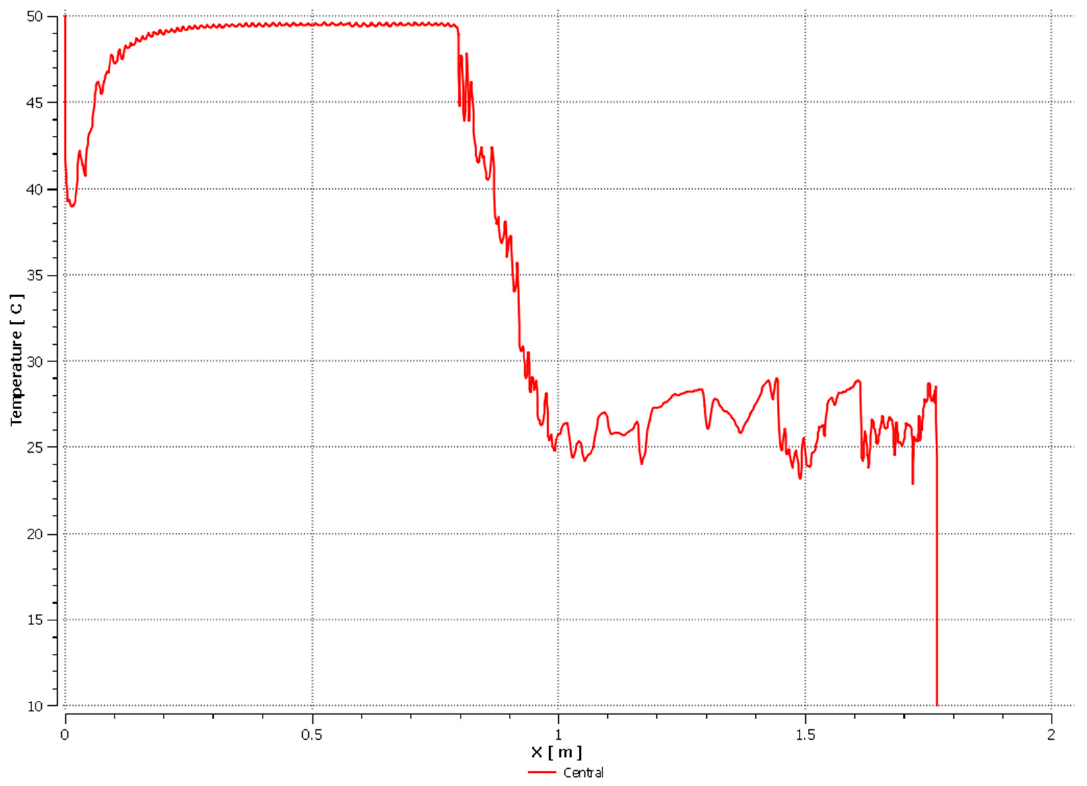
Figure 14. Temperature distribution along the height along the central line of the heat pipe.